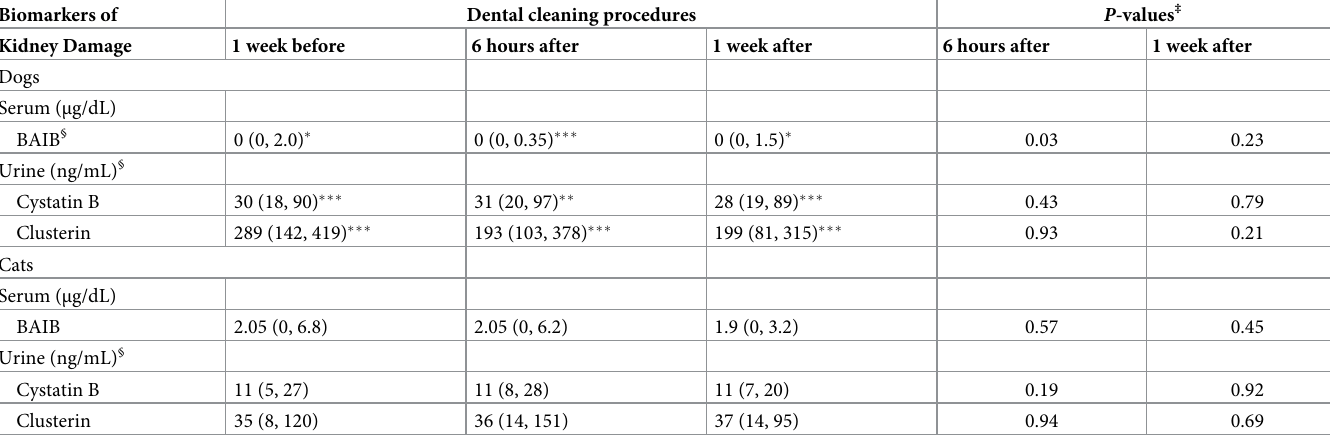
Table 5. Serum and urine kidney tissue damage biomarkers before and after general anesthesia and dental cleaning procedures in cats and dogs with periodontal disease (n = 62) � . Biomarkers of Dental cleaning procedures P -values